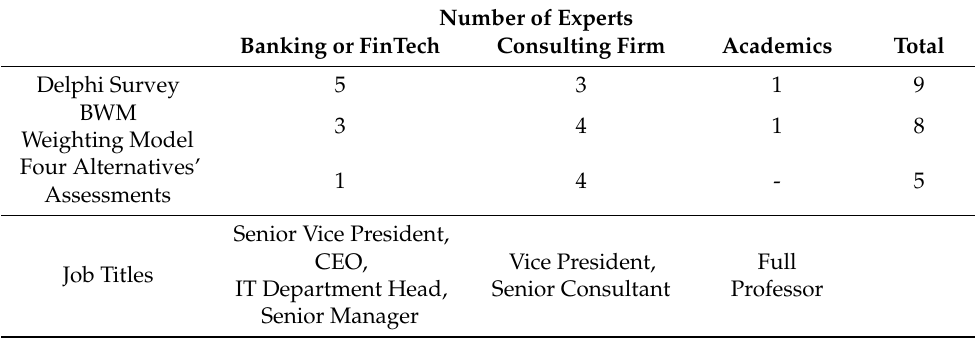
Table 1. Summary of experts’